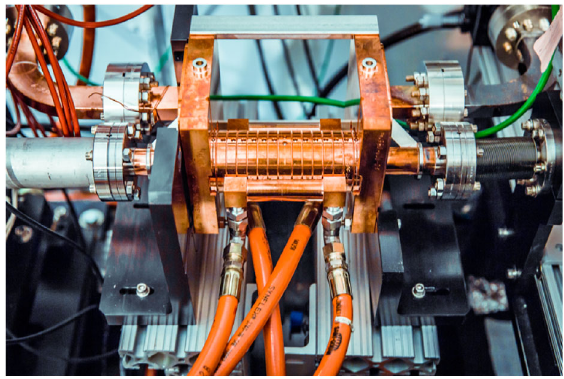
FIG. 15. Raw image of the electron beam streaked by 27-cell X -band deflector at SLAC ’ s NLCTA. FIG. 16. 11-cell deflector installed in X-Band Test